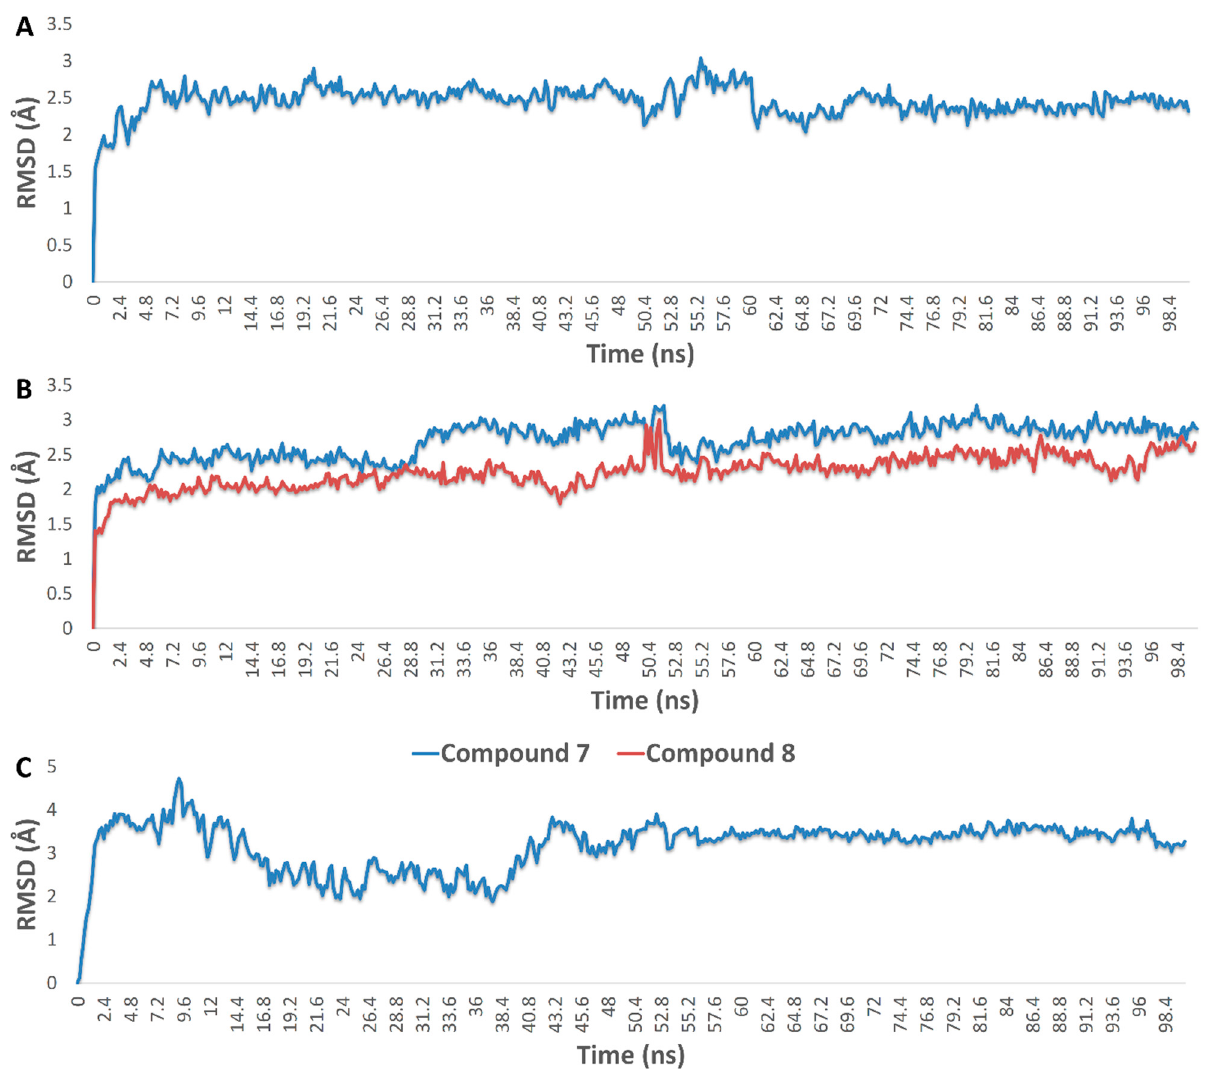
Figure 18. ( A ) RMSDs of compound 7 inside the active site of matrix metalloproteinase-2 (MMP2) over 100 ns MDS; ( B ) binding modes of compounds 7 and 8 inside the active site of matrix metalloproteinase-1 (MMP1) over 100 ns MDS; ( C ) binding mode of compound 12 inside the active sites of serine/threonine-protein kinase PLK1 (PLK1) over 100 ns MDS.